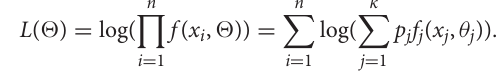
• y : Dates of onset of symptoms of the